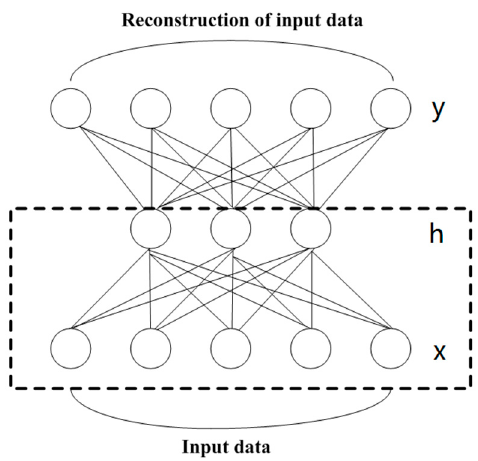
Figure 2. The structure of an SAE. x , h and y are the input data, the hidden data and the reconstruction of input data, respectively.